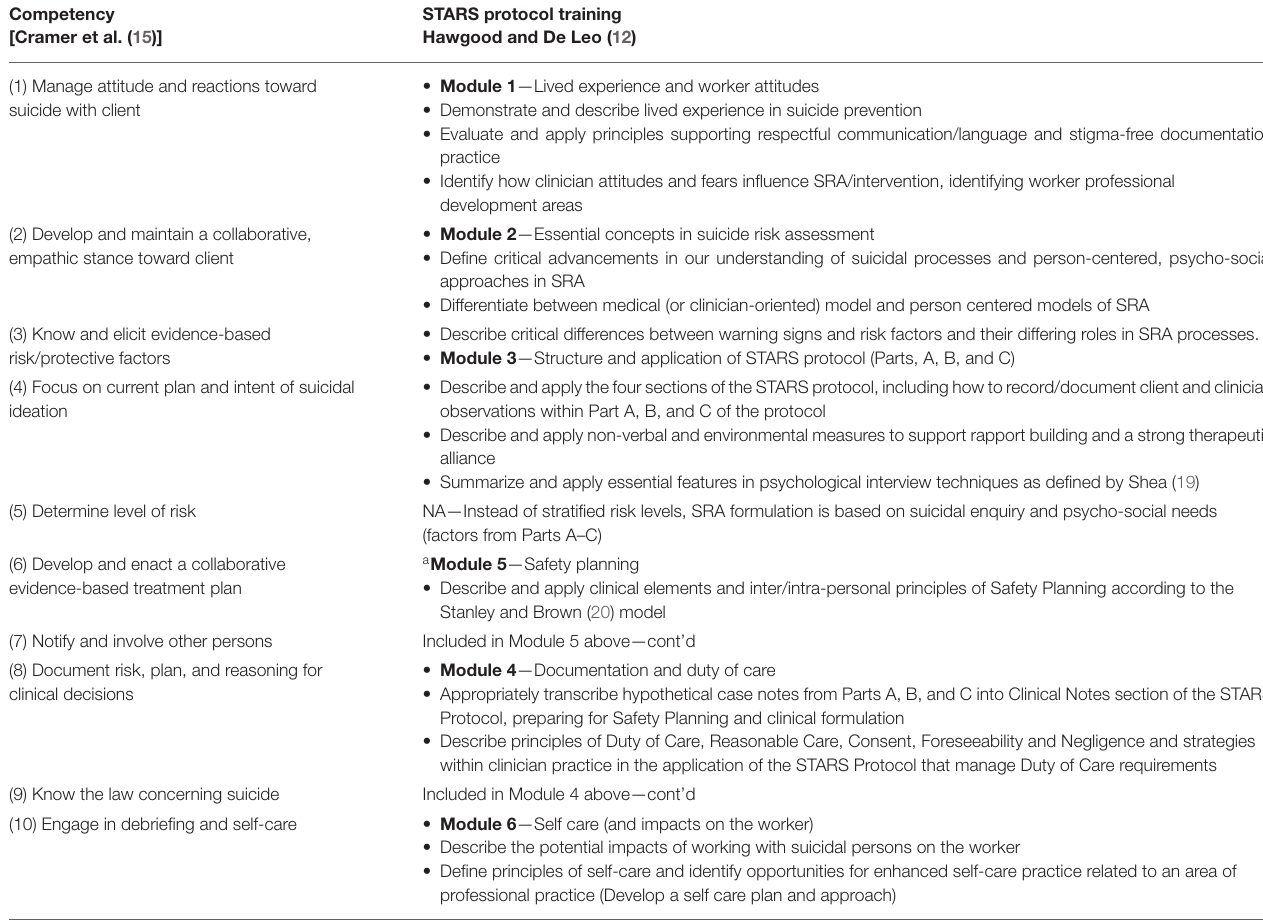
TABLE 1 | Suicide prevention competencies by Cramer et al. (15) and alignment with the STARS protocol training competencies. Competency [Cramer et al.